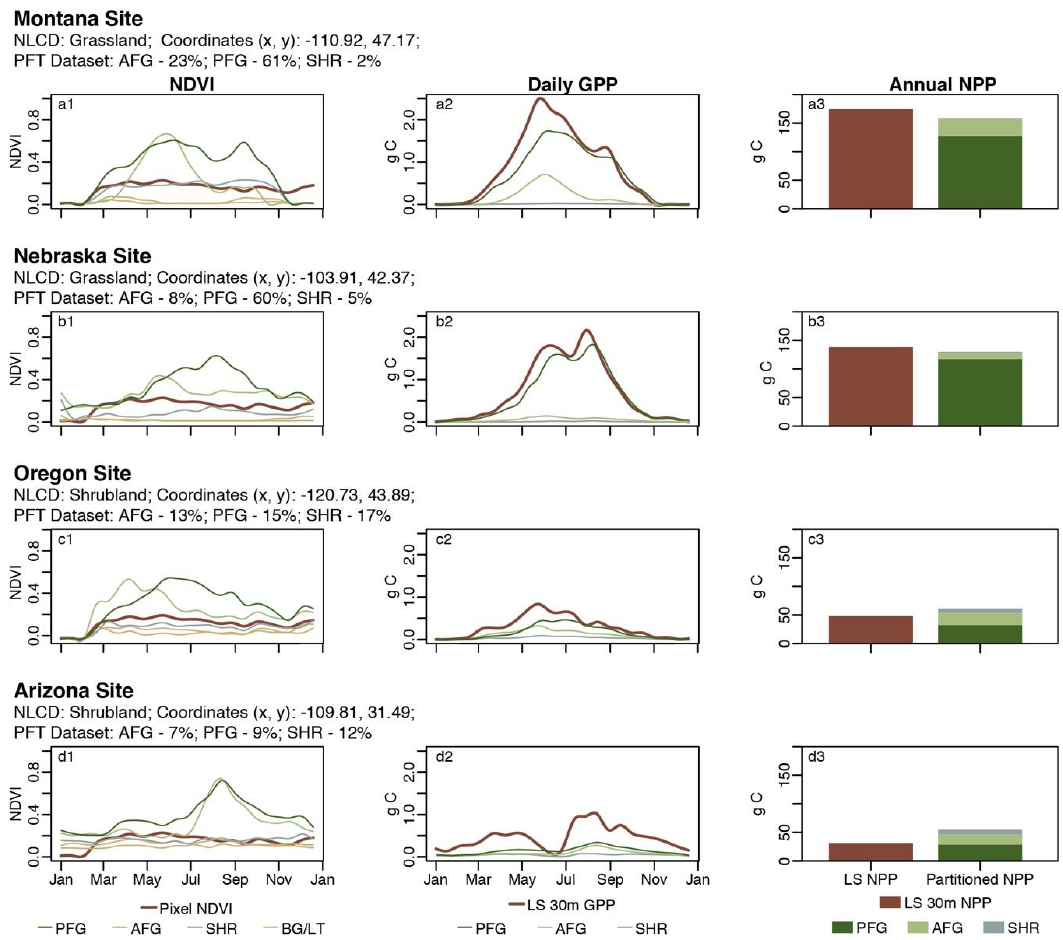
Figure 4. Results of the NDVI disaggregation ( a1 , b1 , c1 , d1 ), GPP partitioning ( a2 , b2 , c2 , d2 ), and NPP partitioning ( a3 , b3 , c3 , d3 ) from four example sites across western US rangelands. The red line/bar represent the pixel results before NDVI disaggregation and GPP/NPP partitioning. For each example site, results are for a single pixel for the year 2017. The NLCD classification, pixel coordinates and the PFT breakdown are shown.